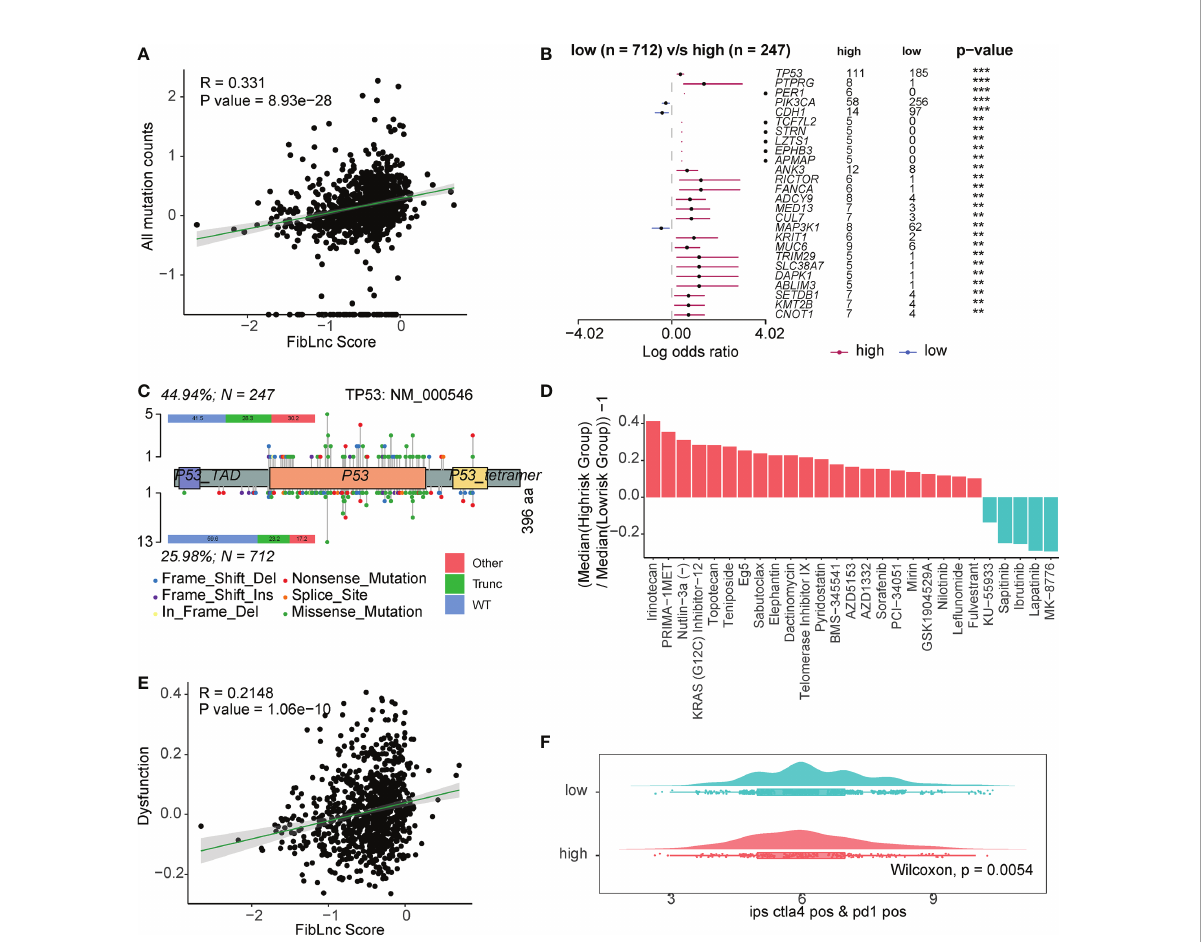
FIGURE 5 The FibLnc score predicts therapeutic bene fi ts. (A) Correlation analysis of all mutation counts and FibLnc scores. (B) Mutation landscape difference between high- and low-risk subgroups. (C) Lollipop chart displaying mutation sites of TP53 proteins. (D) The ratio of normalized IC50 value of the 198 drugs between the high- and low-risk subgroups. (E) Correlation analysis of tumor-in fi ltrating immune cell dysfunction scores and FibLnc scores. (F) Distribution of IPS score of patients under anti-CTLA-4 or anti-PD-1 treatment between high- and low-risk